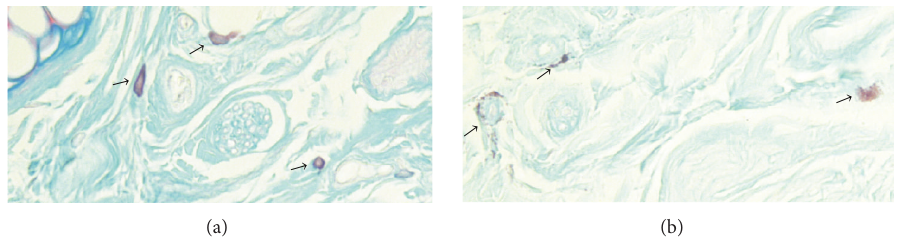
Figure 2: (a) Normal mast cells ( → ) localized near vasculonervous structures in hairy skin. Alcian blue-Safranin O staining. 400x magnification; (b) Degranulated mast cells ( → ) in immediate vicinity of vasculonervous structures in glabrous skin. Alcian blue-Safranin O staining. Magnification